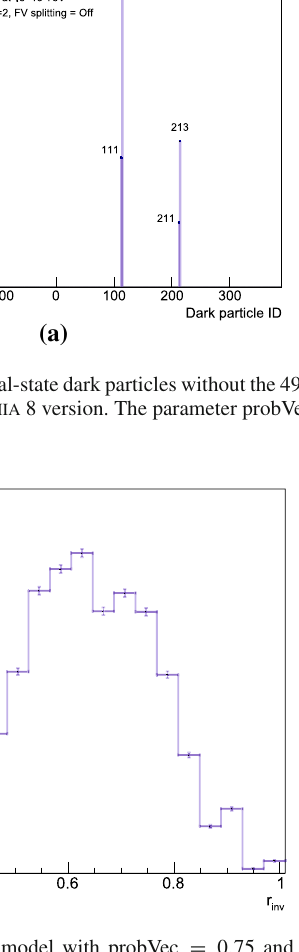
Fig. 26 Distribution of r inv for a model with probVec = 0 . 75 and unstable diagonal ρ D